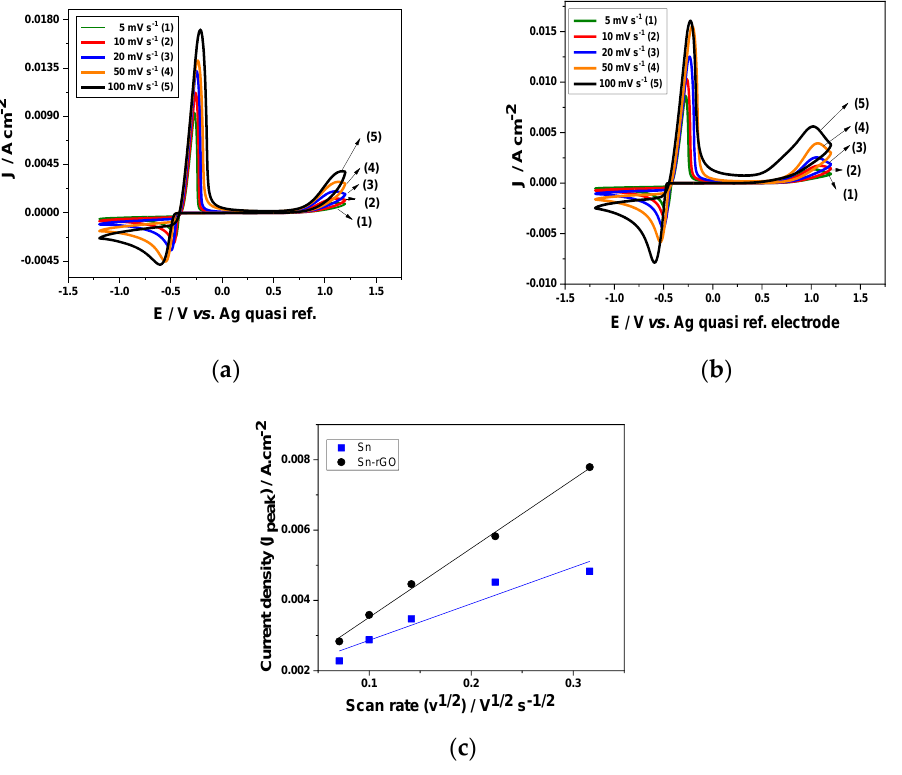
Figure 3. Cyclic voltammograms on GC electrode in ILEG containing: ( a ) 0.05 M SnCl 2 and ( b ) 0.05 M SnCl 2 + 20 mg L − 1 GO, at different scan rates, 25 °C; ( c ) cathodic peak current density vs. square SnCl 2 + 20 mg L − 1 GO, at different scan rates, 25 ◦ C; ( c ) cathodic peak current density vs. square root root of scan rate. of scan